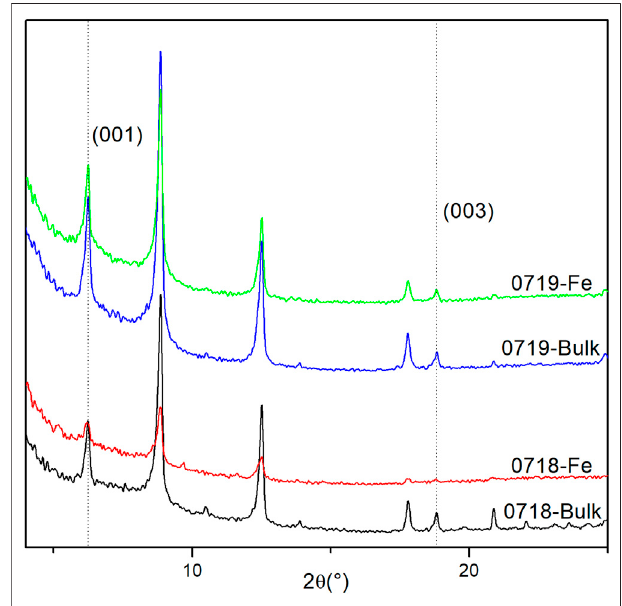
FIGURE 4 | X-ray diffraction patterns between 5 ° and 18 ° of the bulk deposits and rusty parts from samples 0718 and 0719. The d (001) values are the same as the bulk